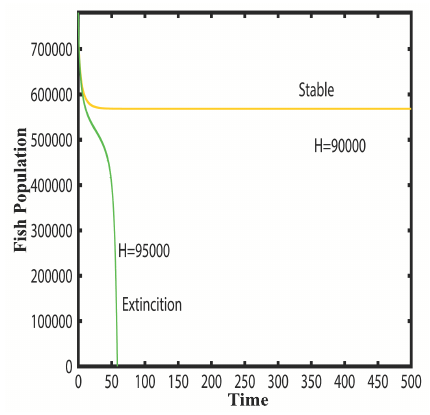
Figure 1. Stability and extinction line for Constant harvesting rates.